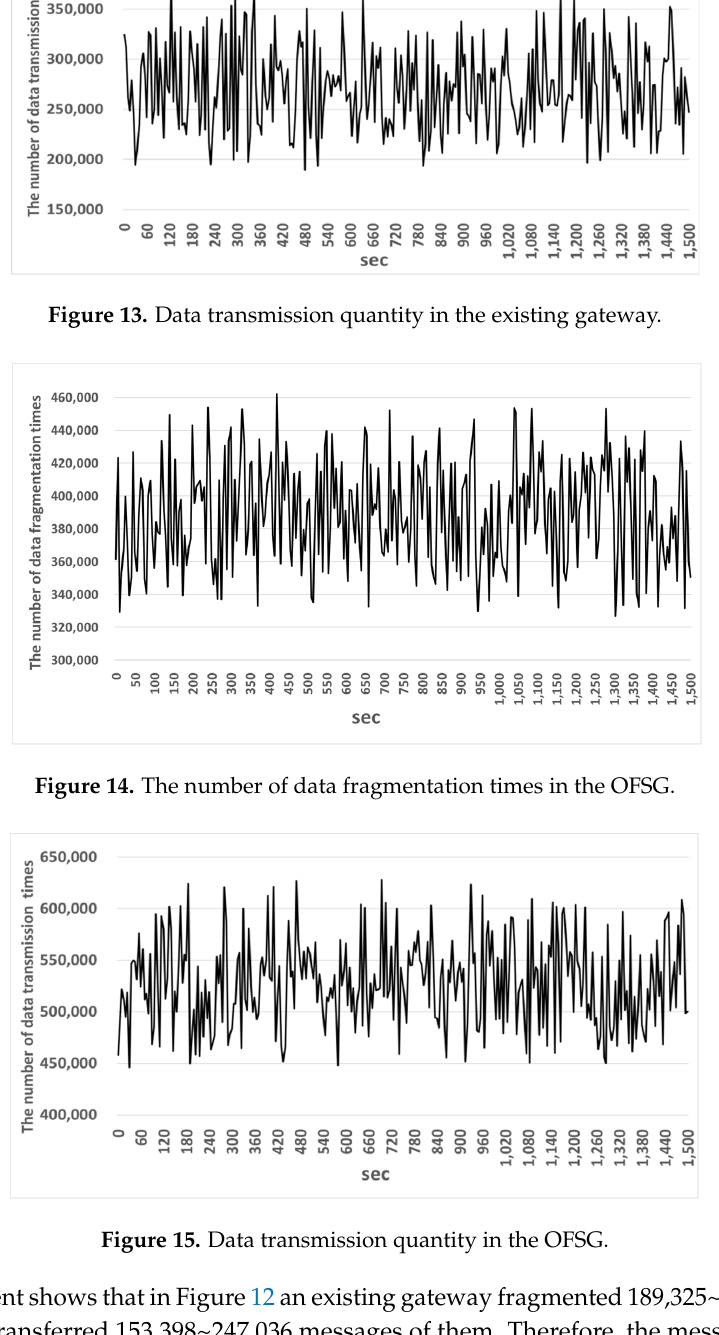
Figure 12. The number of data fragmentation times in the existing gateway.